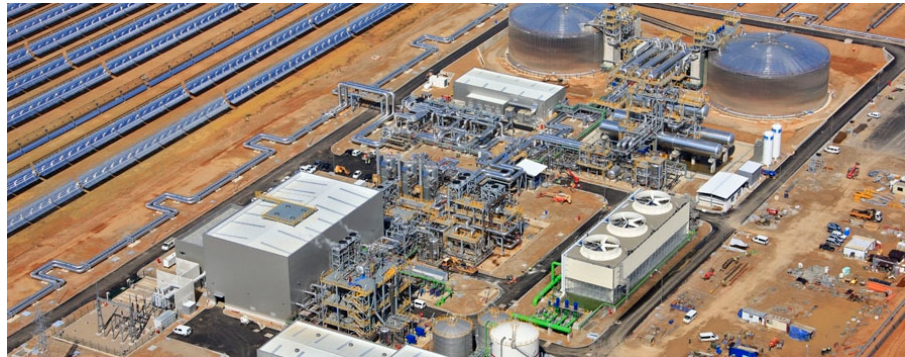
Figure 1. General view of “La Africana”. Hot and cold tanks are shown at the top, with the heat exchanger in between. The solar collectors are located at the left of the image. exchanger in between. The solar collectors are located at the left of the In “La Africana”, it is possible to store energy to supply electricity for 7.5 h; a more detailed description can be found in [7]. This plant uses well-known parabolic trough collectors.